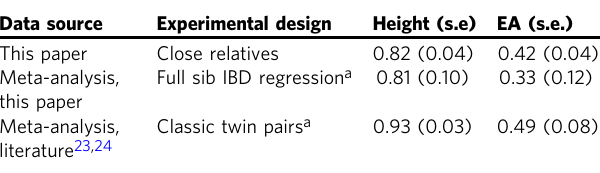
Table 4 Estimates of the equilibrium heritability for height and EA from different experimental designs, using adjustments for assortative mating where appropriate a